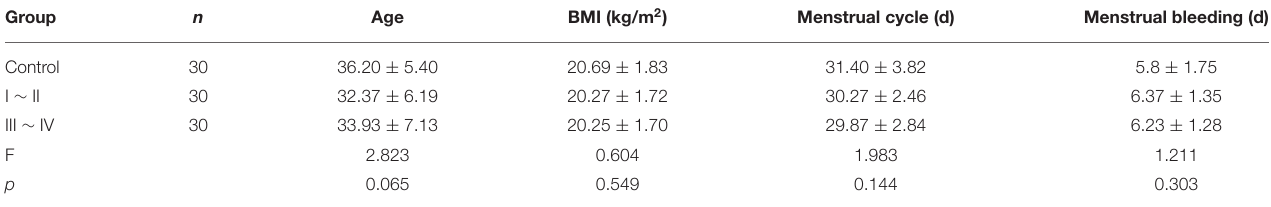
TABLE 4 | Comparison of general data of clinical patients.